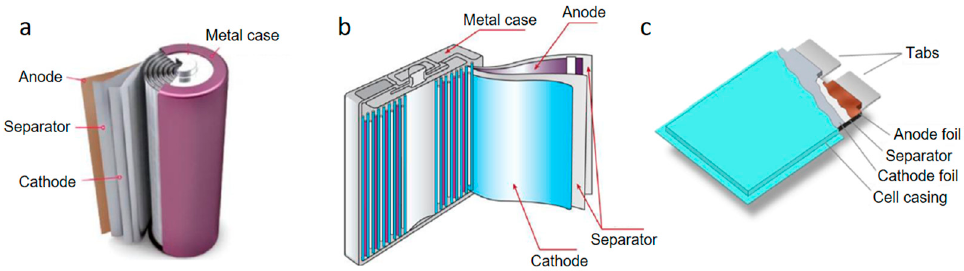
Figure 2. Schematics of inner structures of commercial LIBs. ( a ) Cylindrical-type, ( b ) prismatic-type, and ( c ) pouch-type cells. Reproduced with permission from [3].